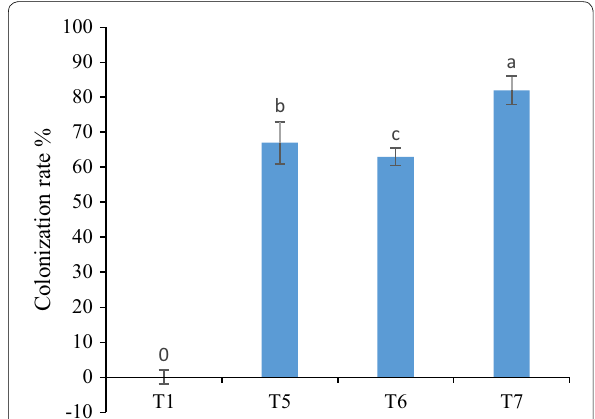
Fig. 1 Arbuscular mycorrhizal fungi infection rate of plant root after harvest in co-inoculated